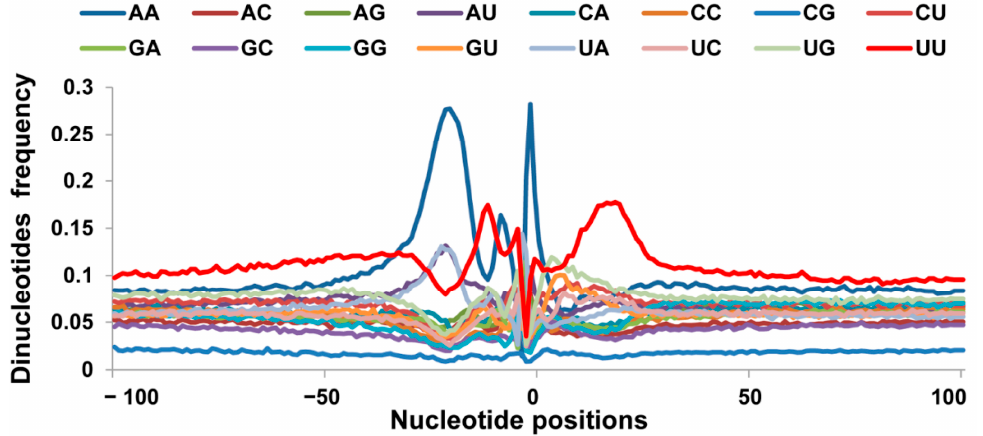
Figure 3. Distribution frequency of the dinucleotides within the 100 bp of the cleavage site. Dinu- cleotide profiles downstream of the poly(A) sites were determined to explore U/GU richness. The Y -axis represents the ratio of nucleotide number to total PAS number. Downstream of the poly(A) site was from − 100 to 100 relative to the CS at position